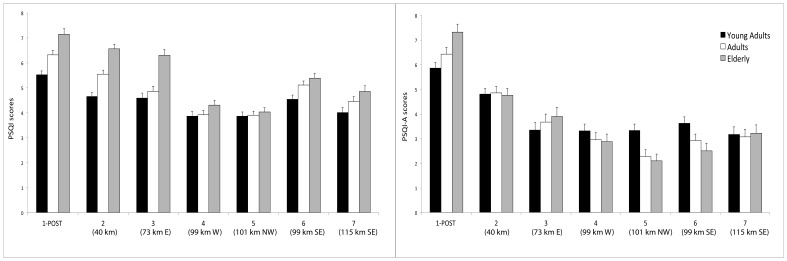
Mean scores (±SEM) to the Pittsburgh Sleep Quality Index (PSQI; left panel) and to the Pittsburgh Sleep Quality Index-Addendum (PSQI-A; right panel) for the seven geographic groups divided in three age subgroups (Young Adults, Adults and Elderly).Please see the Results section for more details.